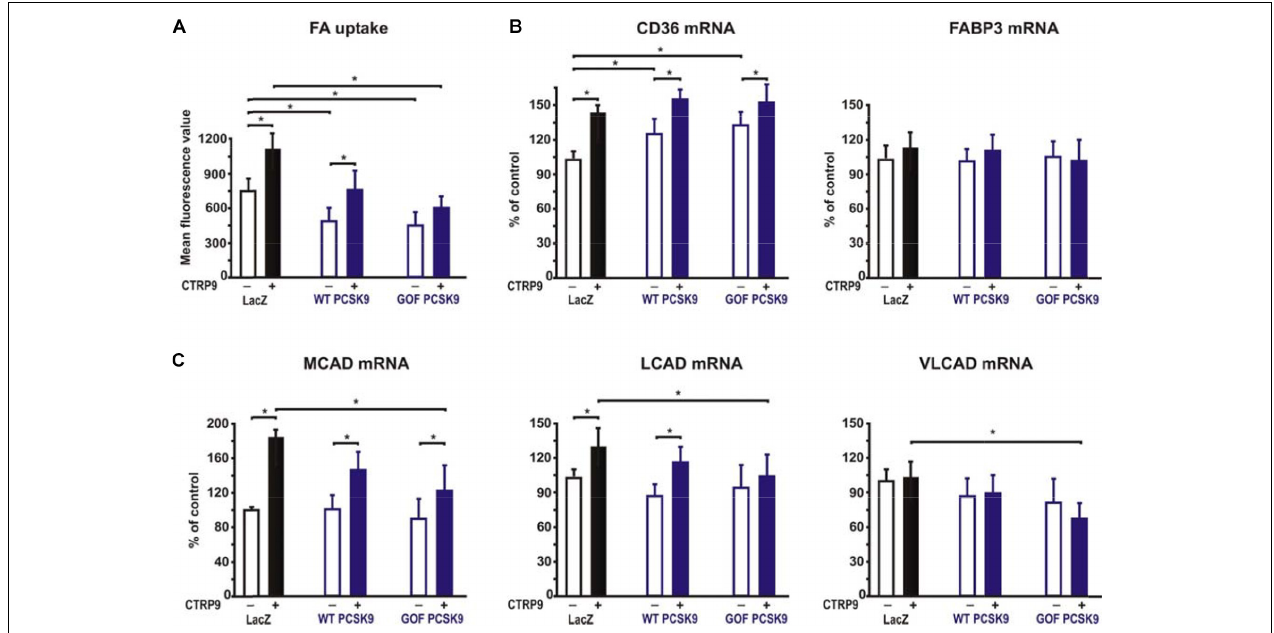
FIGURE 8 | Impact of PCSK9 on CTPR9-induced effects on fatty acid metabolism. Adult rat cardiomyocytes were incubated in the presence of LacZ-containing supernatant (control), murine wild-type PCSK9 or GOF PCSK9 (each 0.5 µ g/ml) in serum-free medium for 24 h and subsequently treated with CTRP9 (4 µ g/ml) for the indicated times. (A) FA uptake was analyzed following 30 min stimulation with CTRP9 using the fluorescent long-chain FA analog BODIPY TM 500/510 C1, C12. (B,C) Changes in the mRNA expression of the FA transporter CD36 or FABP3 (B) and enzymes of the FA oxidation MCAD, LCAD and VLCAD (C) were analyzed by Real-time PCR. All data are mean ± SEM, 4 independent experiments, n = 8 per group, * p <